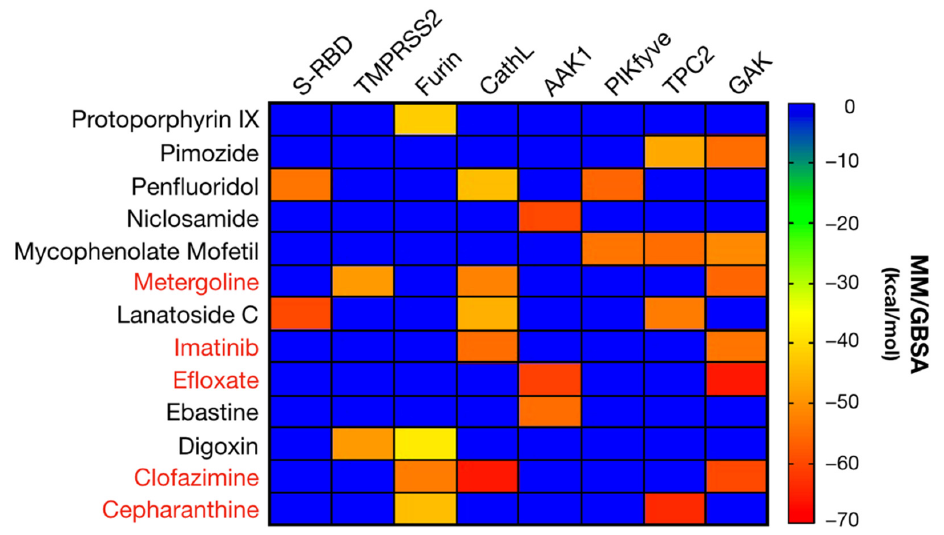
Figure 5. Heat matrix showing the potential targets for the 13 confirmed positive FDA compounds from Table S4 based on their MM/GBSA scores. The five finally identified as entry inhibitors are highlighted in red.